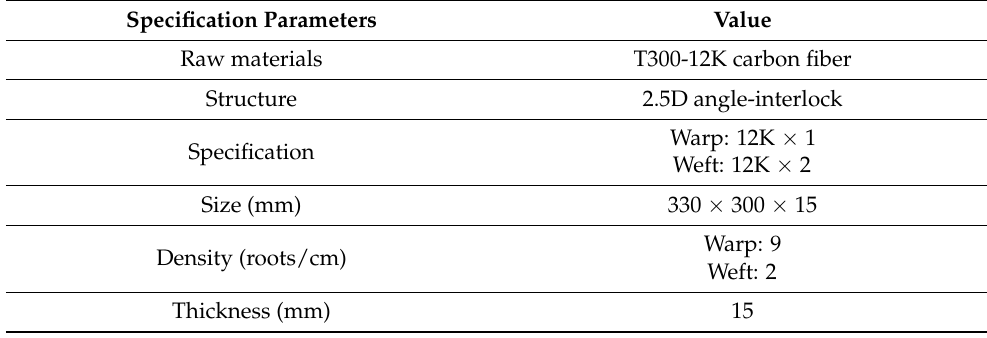
Table 1. Prefabricated fabric parameters.